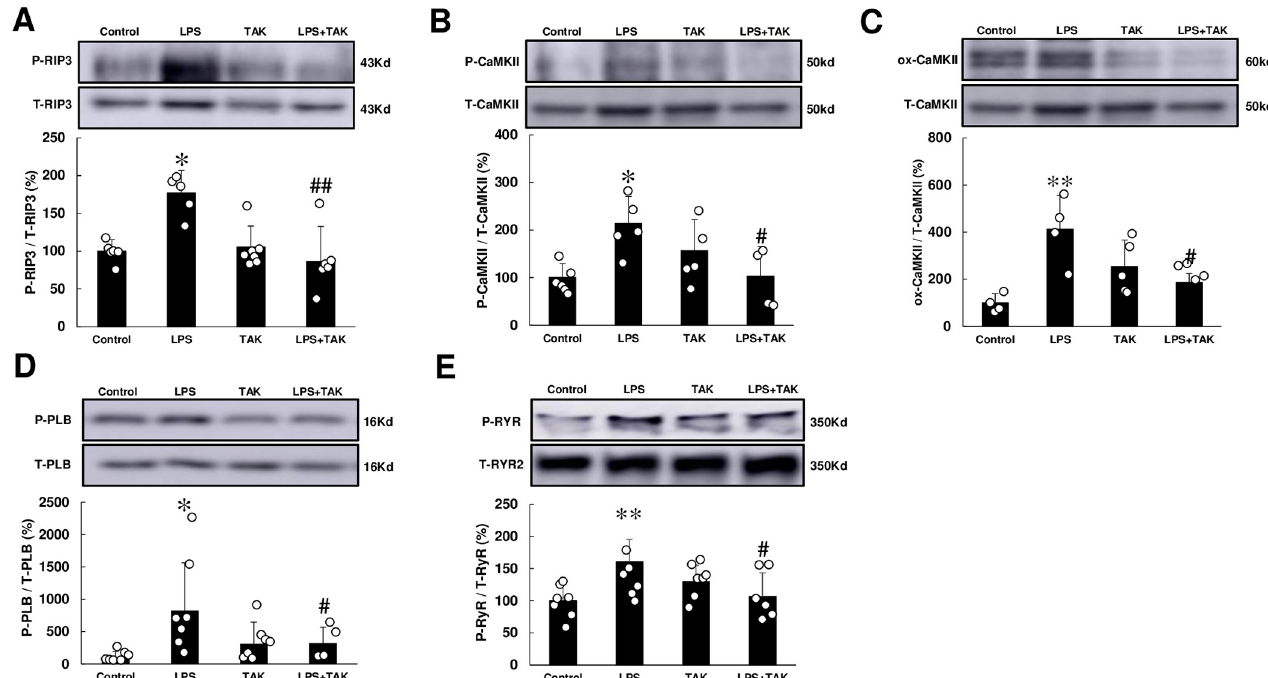
Fig 5. Effects of chronic PG-LPS infusion on RIP3, CaMKII, PLN, RyR2 in the heart. (A) RIP3 phosphorylation (Thr-231/Ser-232) was significantly increased in the PG-LPS group, and this increase was significantly attenuated by TAK-242. � P < 0.05 vs. Control or ## P < 0.01 vs. PG-LPS group by one-way ANOVA followed by the Tukey-Kramer post hoc test. Full-size images of immunoblots are presented in S9 Fig of S1 Data. (B) CaMKII phosphorylation (Thr- 286) was significantly increased in the PG-LPS group, and this increase was significantly attenuated by TAK-242. � P < 0.05 vs. Control or ## P < 0.01 vs. PG-LPS group by one-way ANOVA followed by the Tukey-Kramer post hoc test. Full-size images of immunoblots are presented in S10 Fig of S1 Data. (C) CaMKII oxidation was significantly increased in the PG-LPS group, and this increase was significantly attenuated by TAK-242. �� P < 0.01 vs. Control or # P < 0.05 vs. PG-LPS group by one-way ANOVA followed by the Tukey-Kramer post hoc test. Full-size images of immunoblots are presented in S11 Fig of S1 Data. (D) PLN phosphorylation (Thr-17) was significantly increased in the PG-LPS group, and this increase was significantly attenuated by TAK-242. �� P < 0.05 vs. Control or # P < 0.05 vs. PG-LPS group by one-way ANOVA followed by the Tukey-Kramer post hoc test. Full-size images of immunoblots are presented in S12 Fig of S1 Data. (E) RyR2 phosphorylation (Ser-2814) was significantly increased in the PG-LPS group, and this increase was significantly attenuated by TAK-242. �� P < 0.01 vs. Control or # P < 0.05 vs. PG-LPS group by one-way ANOVA followed by the Tukey-Kramer post hoc test. Full-size images of immunoblots are presented in S13 Fig of S1 Data. Data show means ± SD and representative immunoblotting are